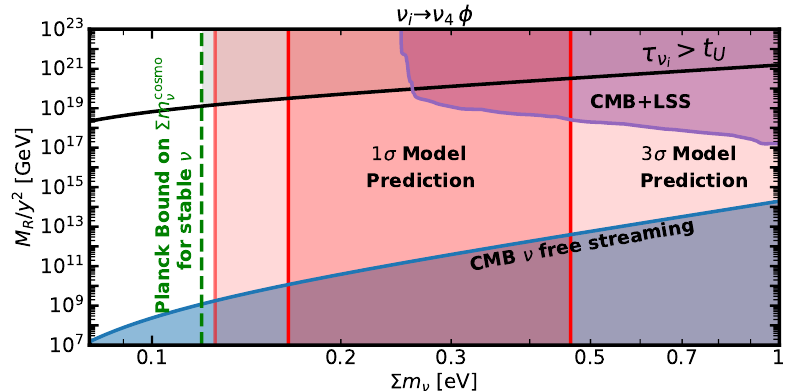
Figure 8 . Parameter space for our proposed model realizing ν i → ν 4 φ decays within a U(1) µ − τ symmetry. We highlight in red the prediction from the U(1) µ − τ mass model required in order to fit at 1 σ and 3 σ neutrino oscillation